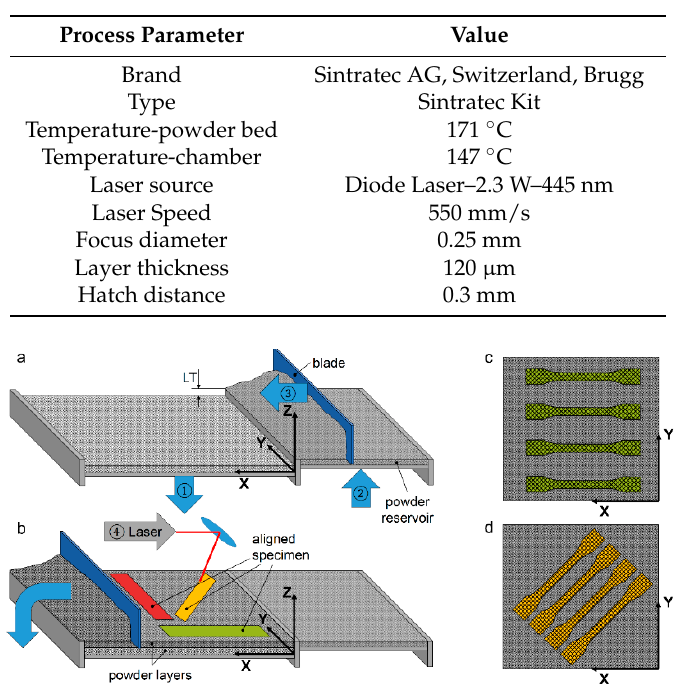
Table 3. Process parameters during SLS.